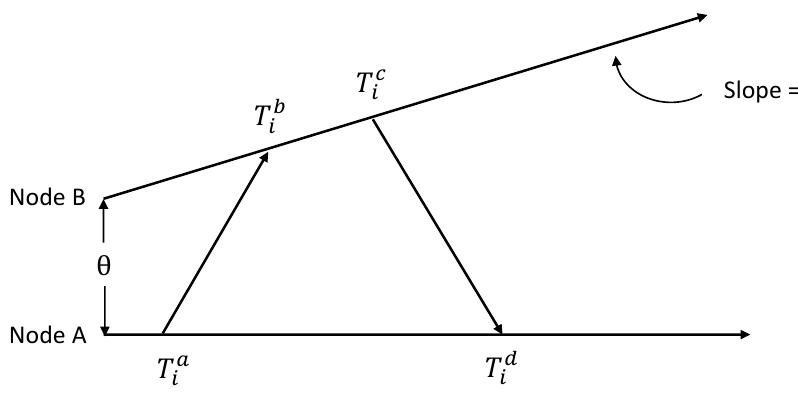
Figure 3. Two-way message exchange mechanism (with